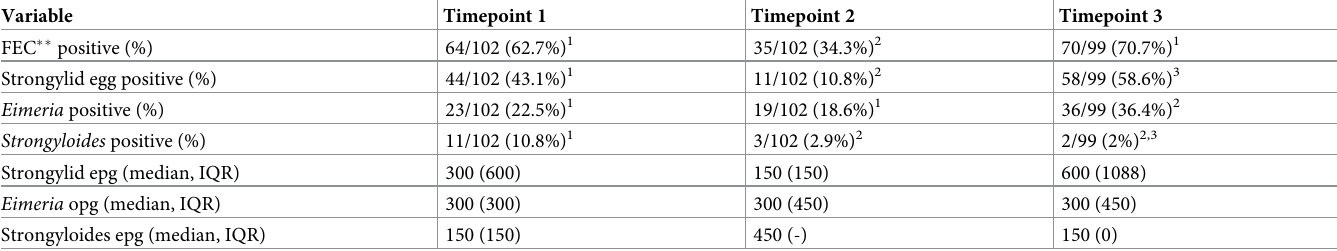
Table 1. Fecal egg counts of 102 clinically healthy alpacas �